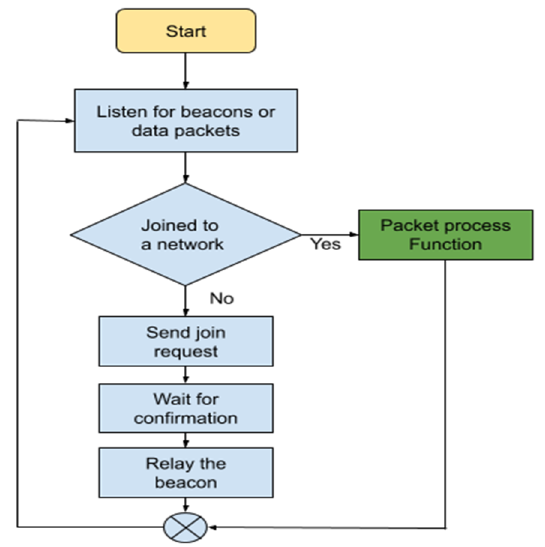
Figure 12. Operation of a Node.